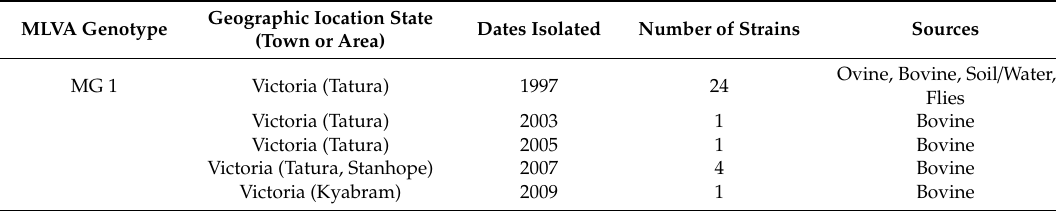
Table 1. Information on strains used in this